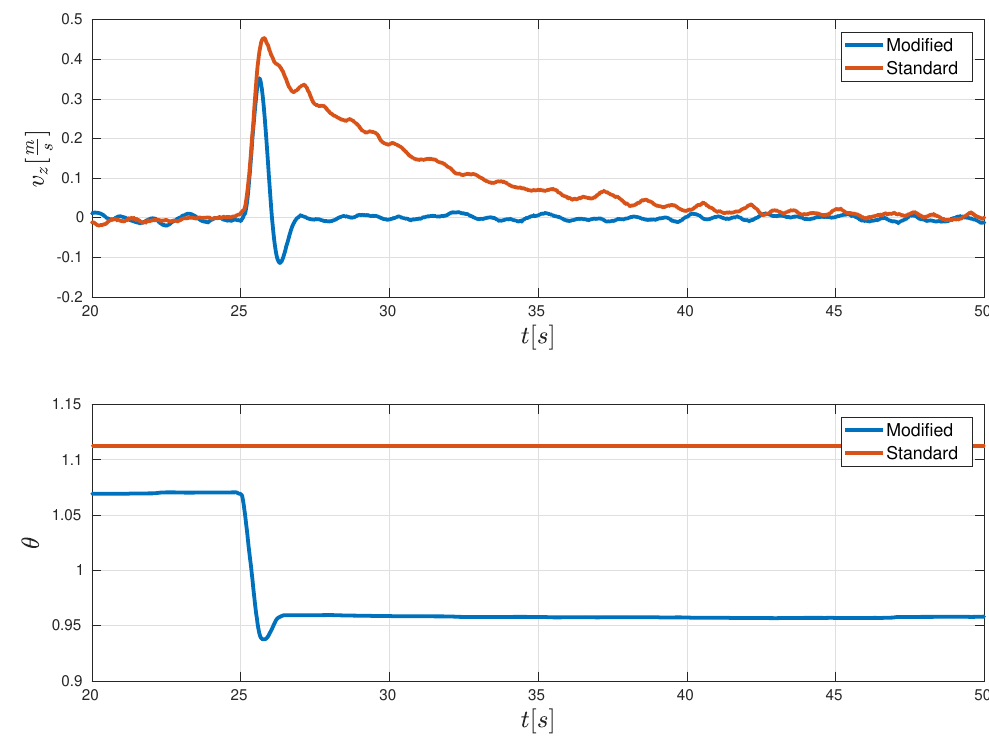
Figure 11. Difference of the new and old approach for